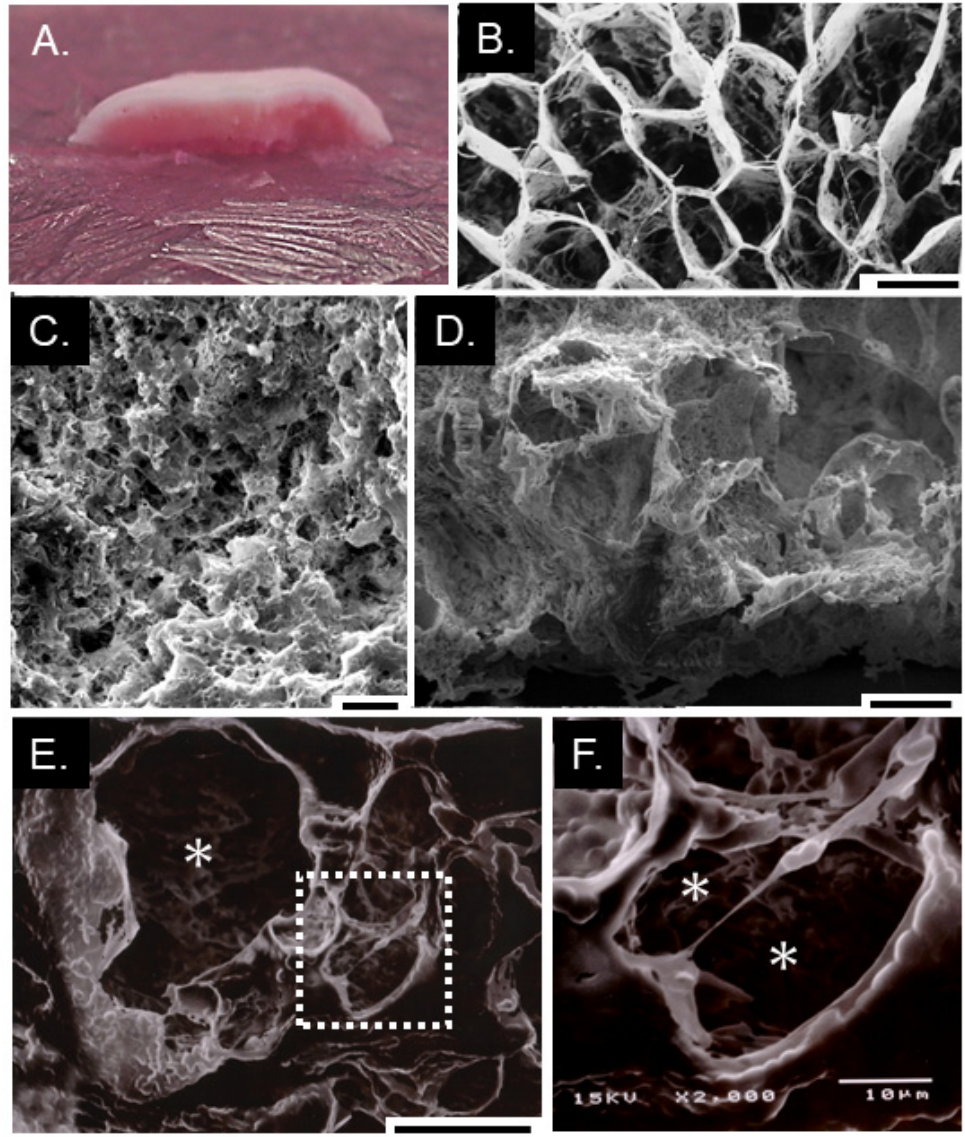
Figure 3. The structure of G. antarctica colony on frozen PDA. Cut surface of the colony on frozen PDA containing red food coloring ( A ). The honeycomb structure of the colony surface ( B ). Sponge-like structure of the center ( C ). Longitudinal section of the bottom ( D , E ). Close-up view of the rectangular in E. * Holes. Bars 100 μ m ( B – D ), 50 μ m ( E ), and 10 μ m ( F ).